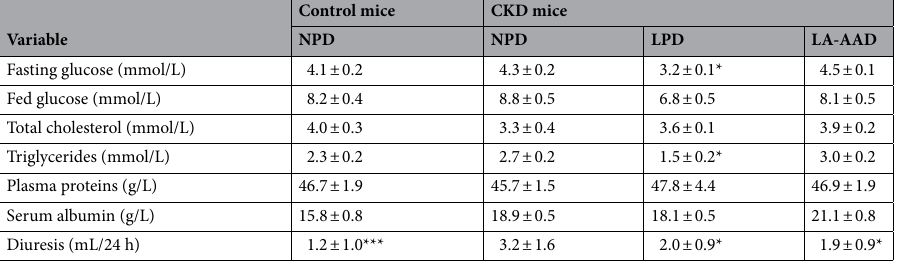
Table 3. Biochemical data. Data are expressed as mean ± SEM for n = 5–12 animals in each group. NPD Normoproteic diet, LPD Low protein diet, LA-AAD Low aromatic amino-acids diet, CKD Chronic kidney